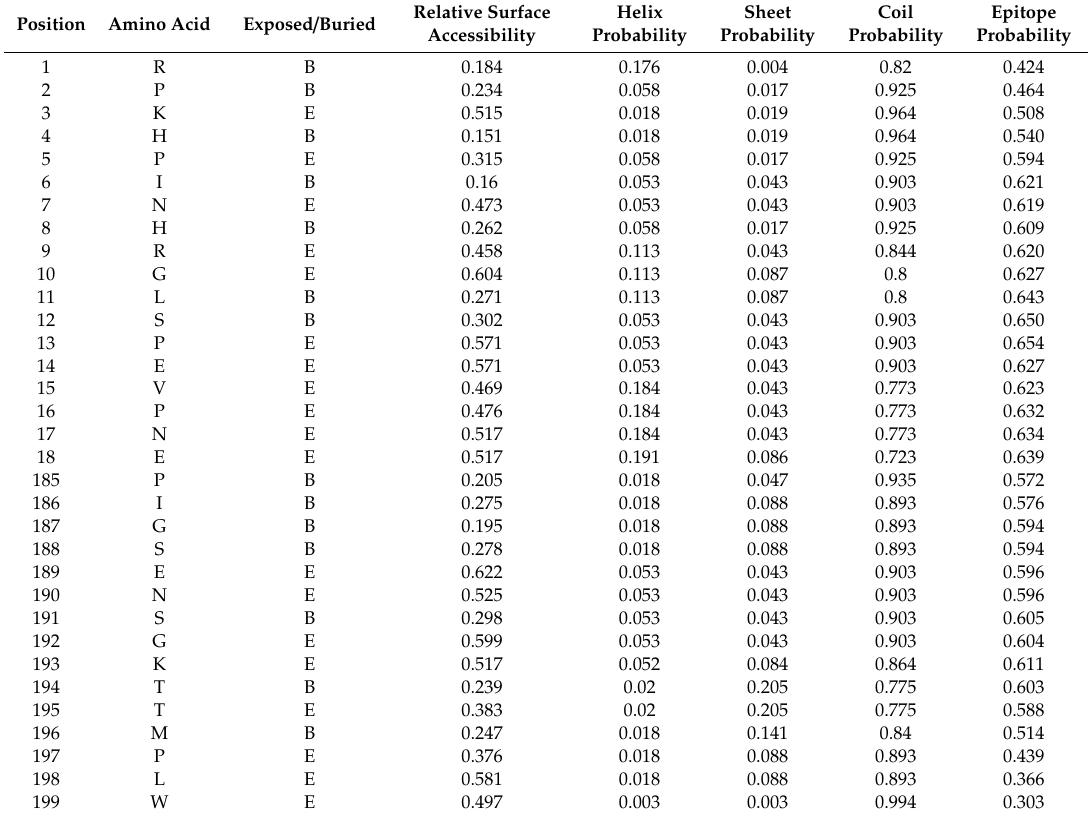
Table 1. Summary results from BepiPred for each amino acid of Nter and Cter peptides, which include helix, sheet, coil and epitope (B-cell)